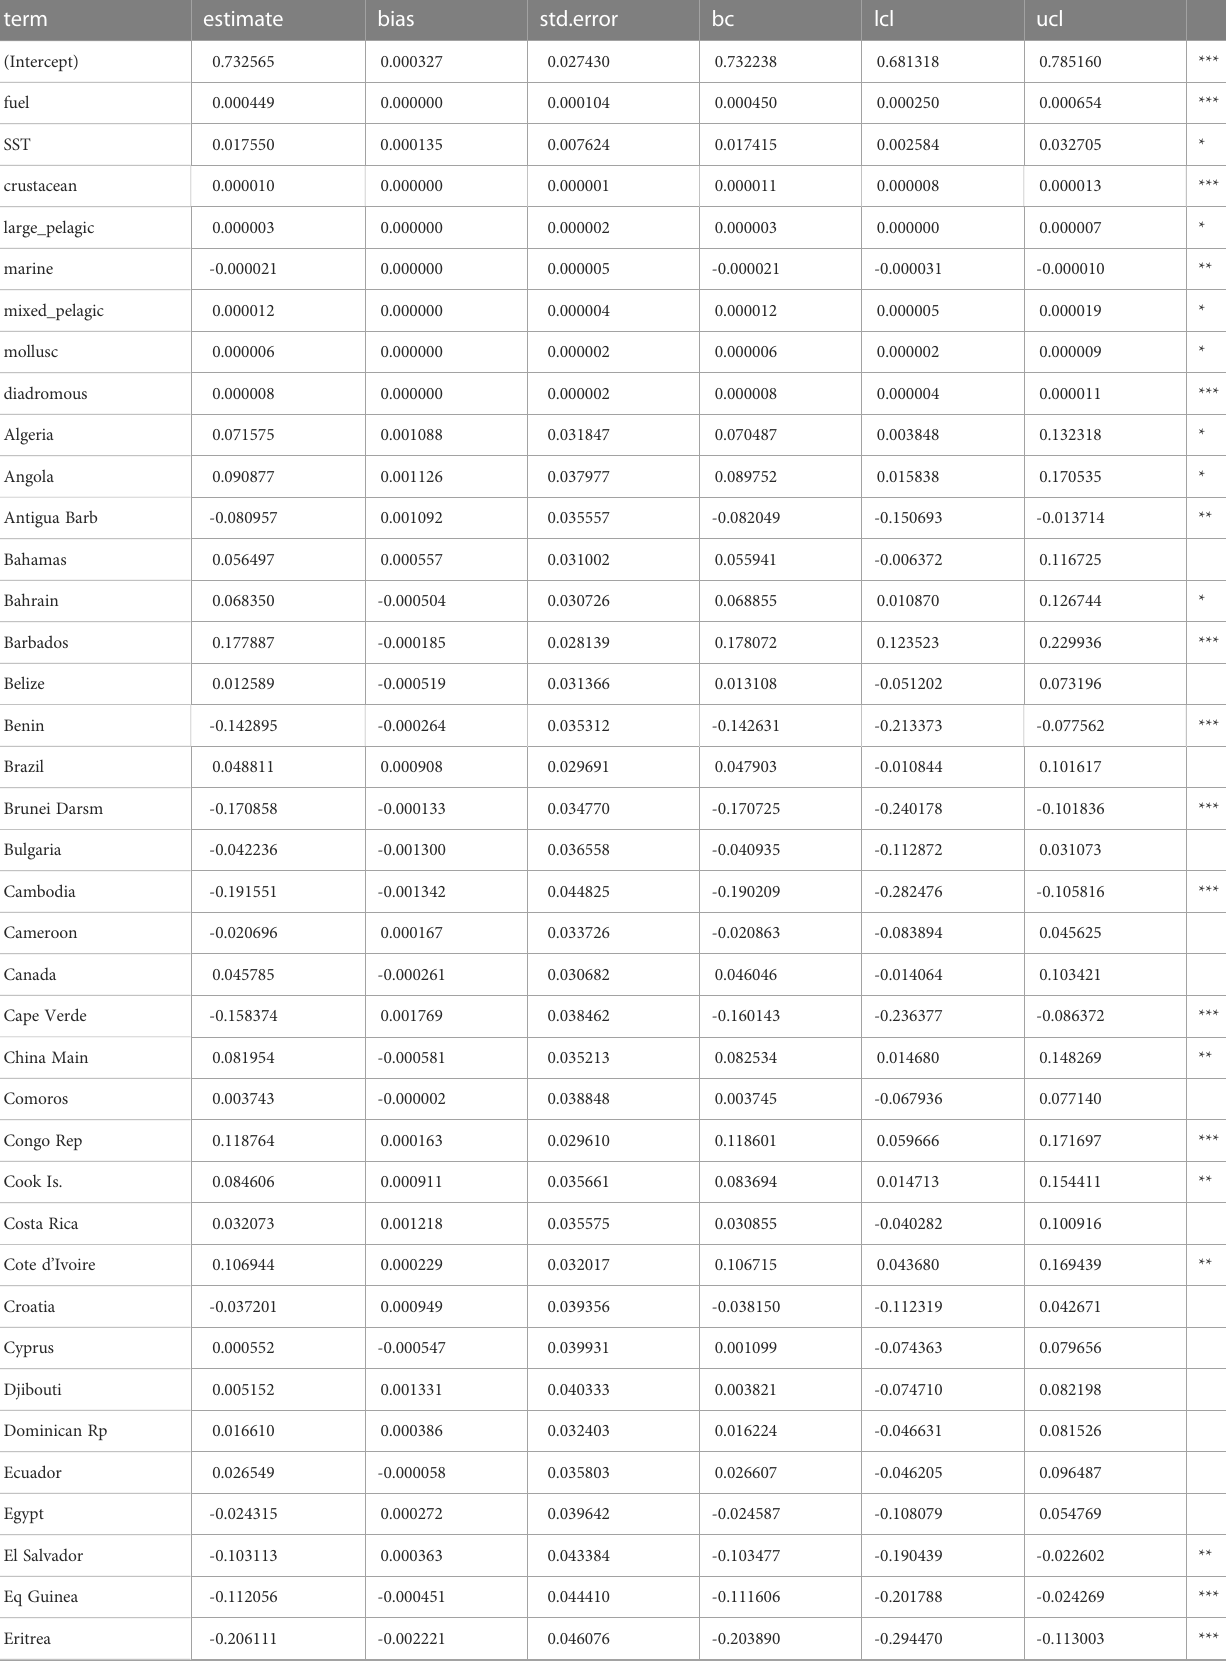
TABLE 3 Model 1 coef fi cient estimates for OLS and bootstrapped OLS (bias-corrected